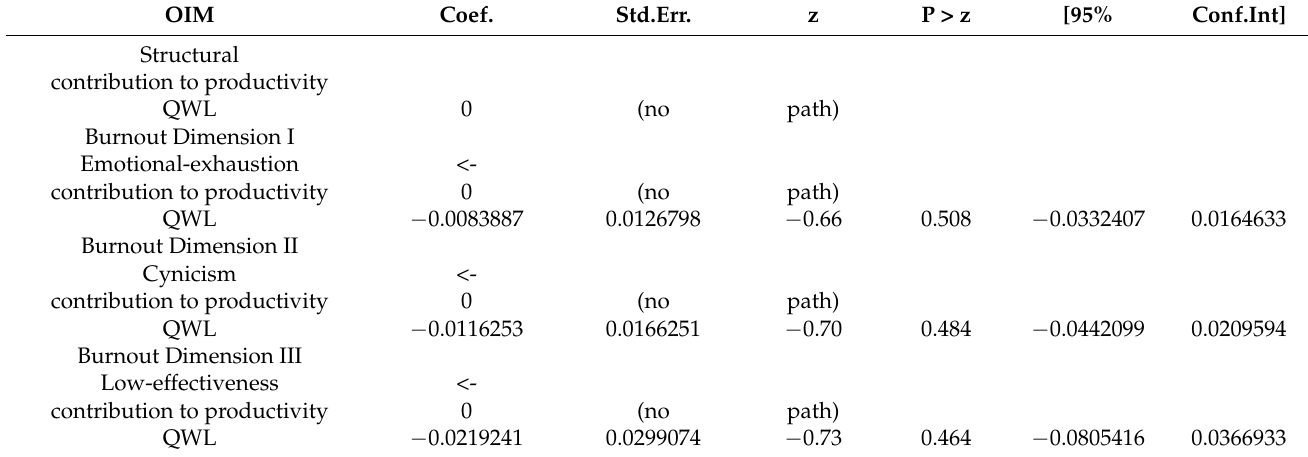
Table 4. Model 1: Indirect effects.